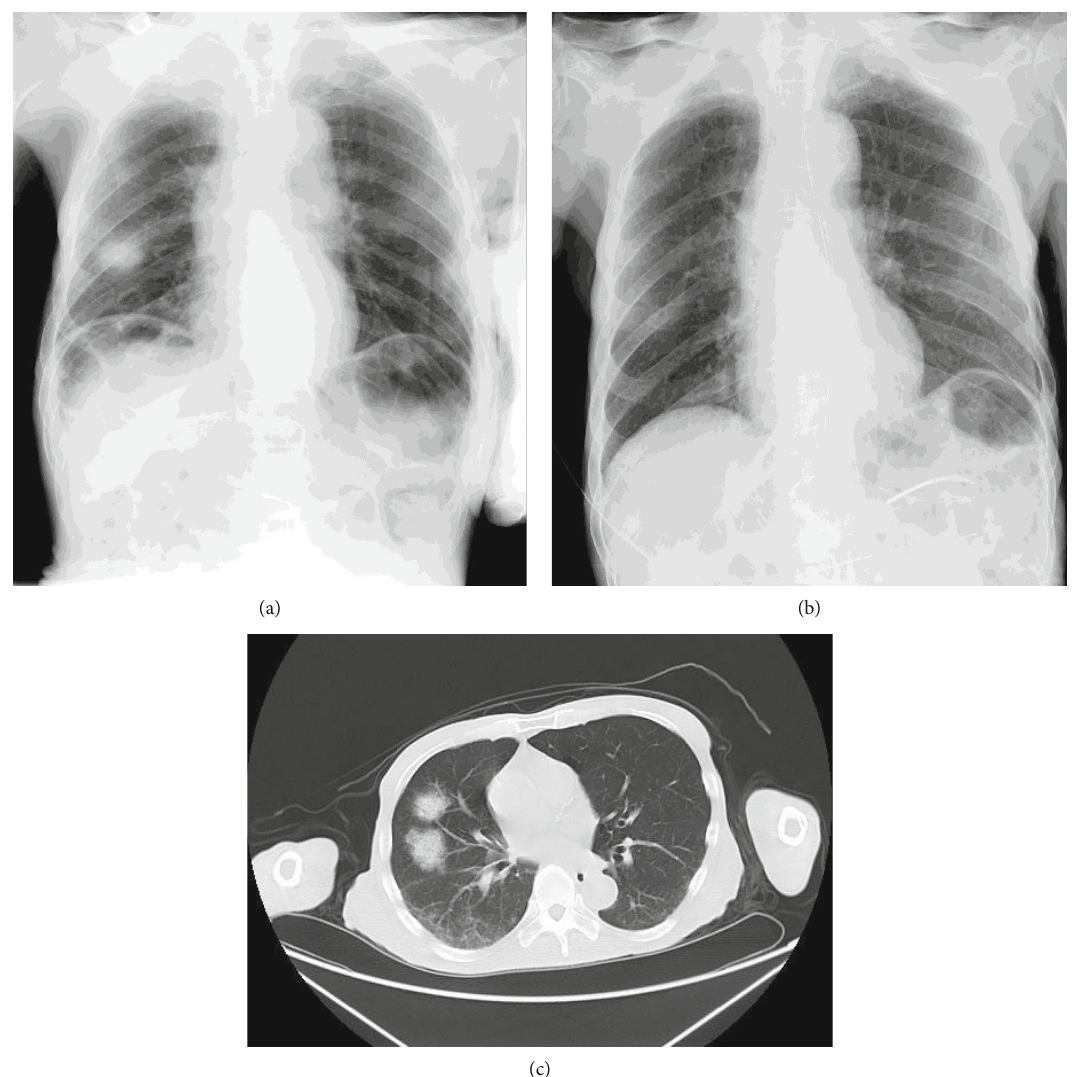
Figure 1: Plain X-ray and CT image. Reticular shadow with ground-glass opacity was observed in the medial lobe of the right lung in the plain X-ray (a) and CT (c) on abnormalities disappeared 45 days later